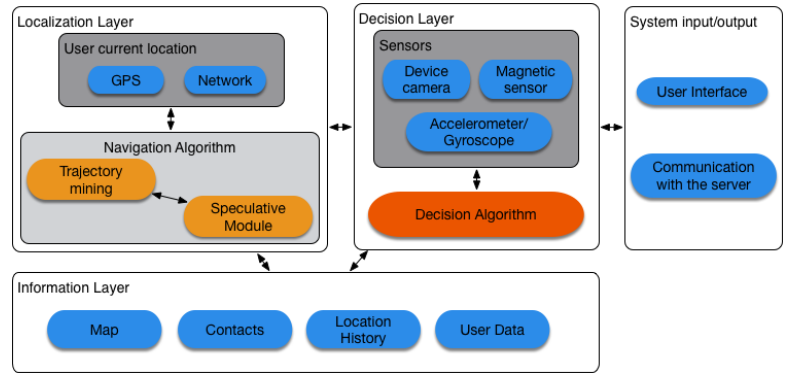
Figure 2. Detailed framework of the application for people with cognitive disabilities.